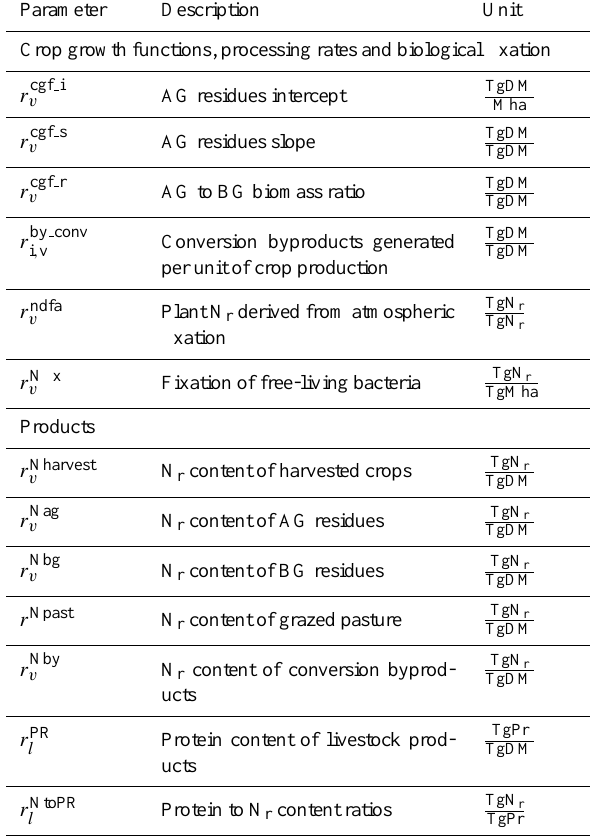
Table A2. Parameters, descriptions and units (all units per year). The name of the equivalent parameter in Eggleston et al. (2006) is indicated in